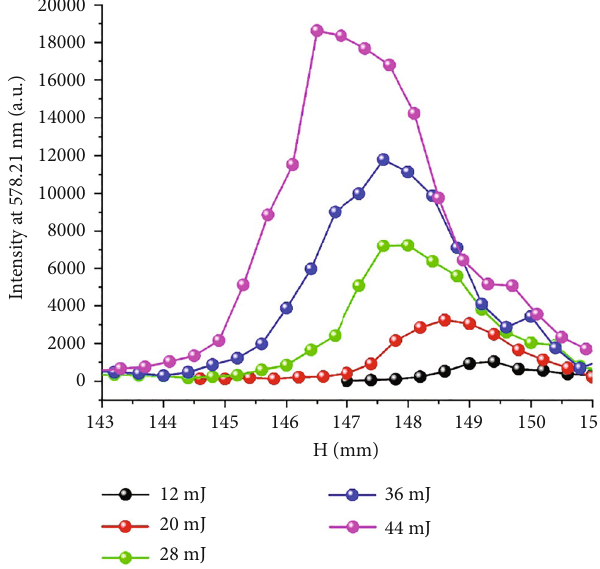
Figure 5: Evolution of spectral intensity with H at di ff erent pulse energies when f = 150 mm.